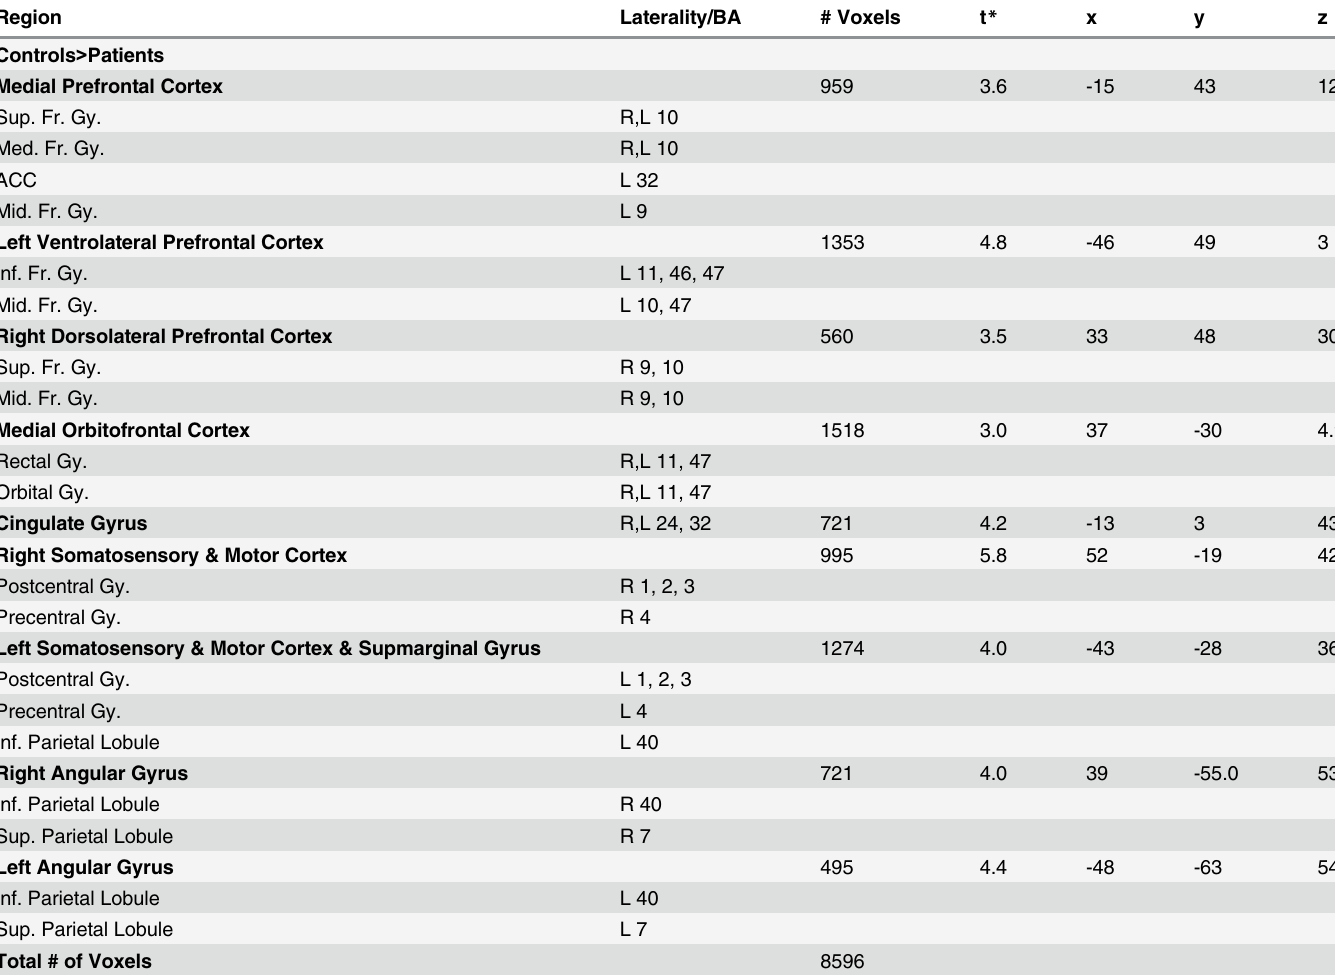
Table 2. Whole brain analysis results where female controls showed greater GM volumes than SCP female